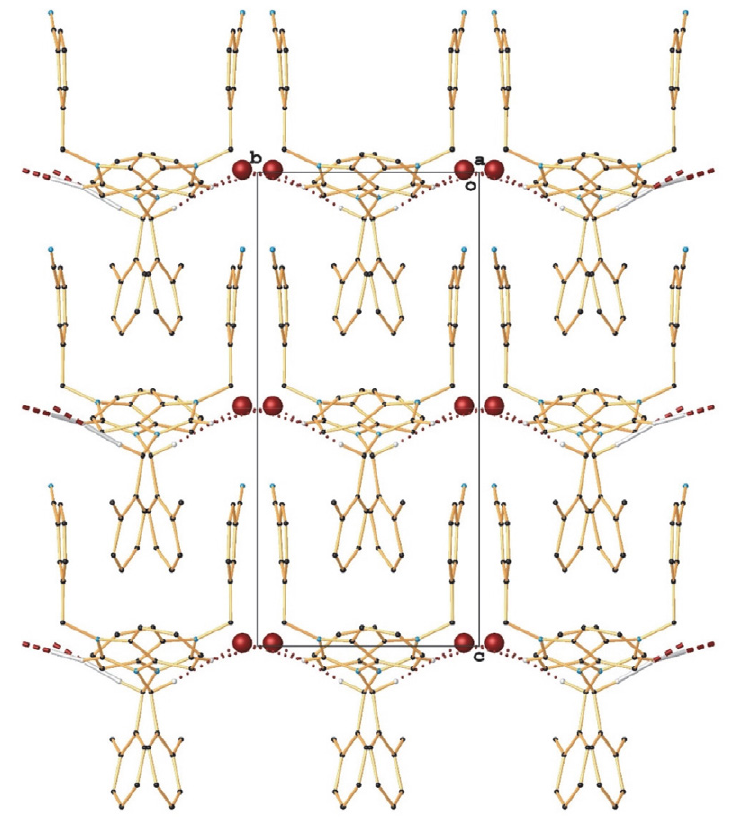
Fig. 3. Graphical representation of pincers-like packing motif the molecules within the unit cell for 2b.